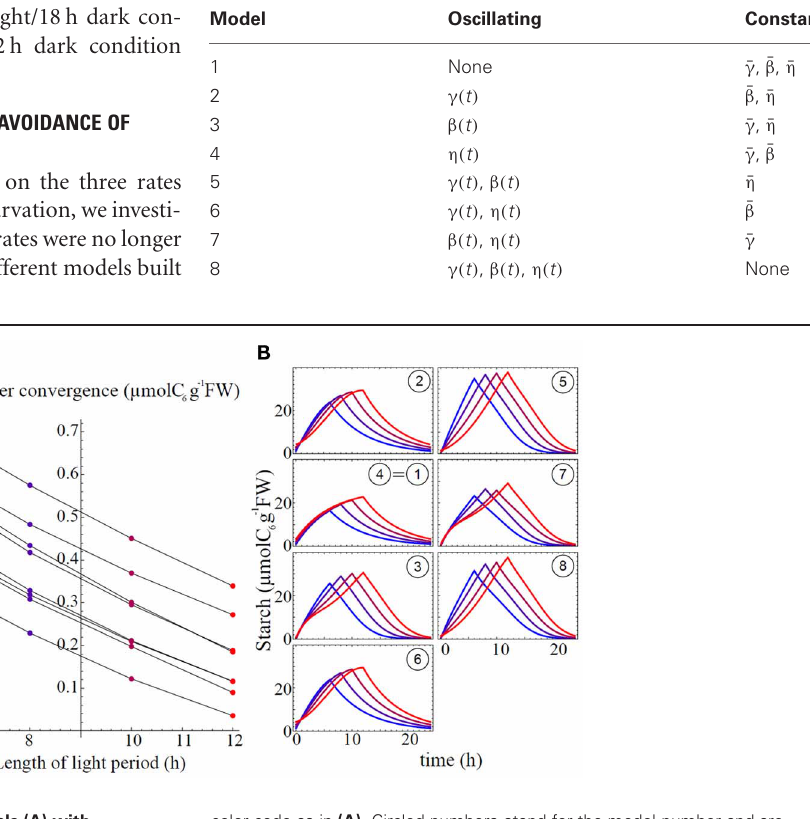
FIGURE 4 | Starvation cost ranking for all the models (A) with associated starch profiles (B). L/D cycles are 6h/18h (blue), 8h/16h (purple), 10h/14h (dark red), and 12h/12h (red). Starch profiles (B) use same